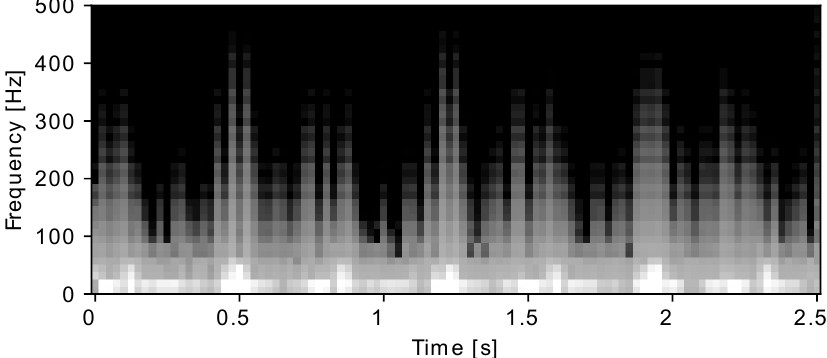
Figure 4. Time–frequency representation of an abdominal ECG segment (single-channel) with a good ground truth quality